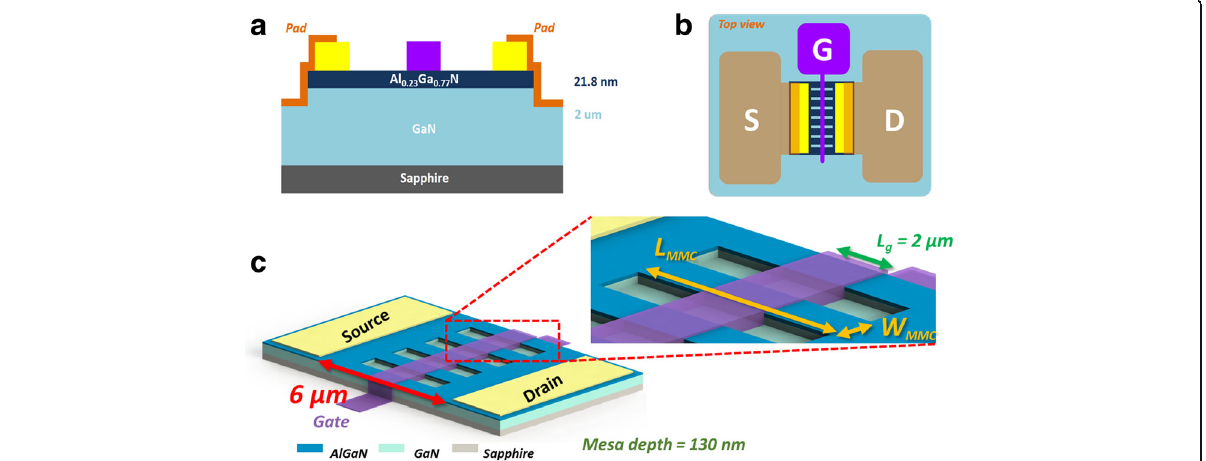
Fig. 1 Schematic representations of a the cross-section of the HEMT structure, viewed from a direction parallel to the transistor channel; b the top-view of the HEMT structure; and c the 3-D structure of the